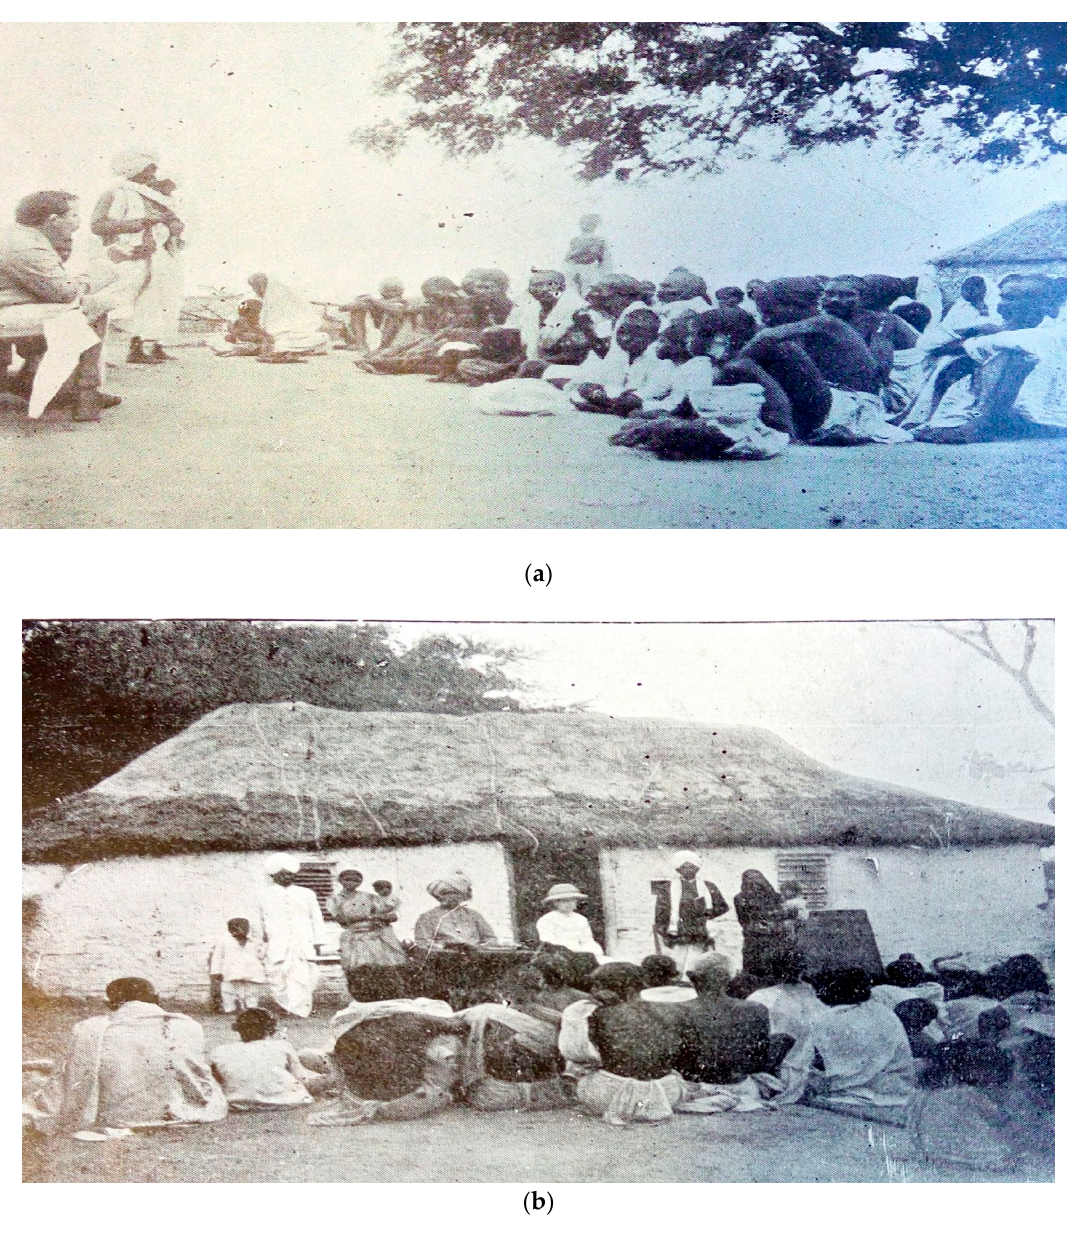
Figure 1. ( a , b ) Dalits interaction with missionaries in palem . Source (Simmons 1923, pp. 7, 12).